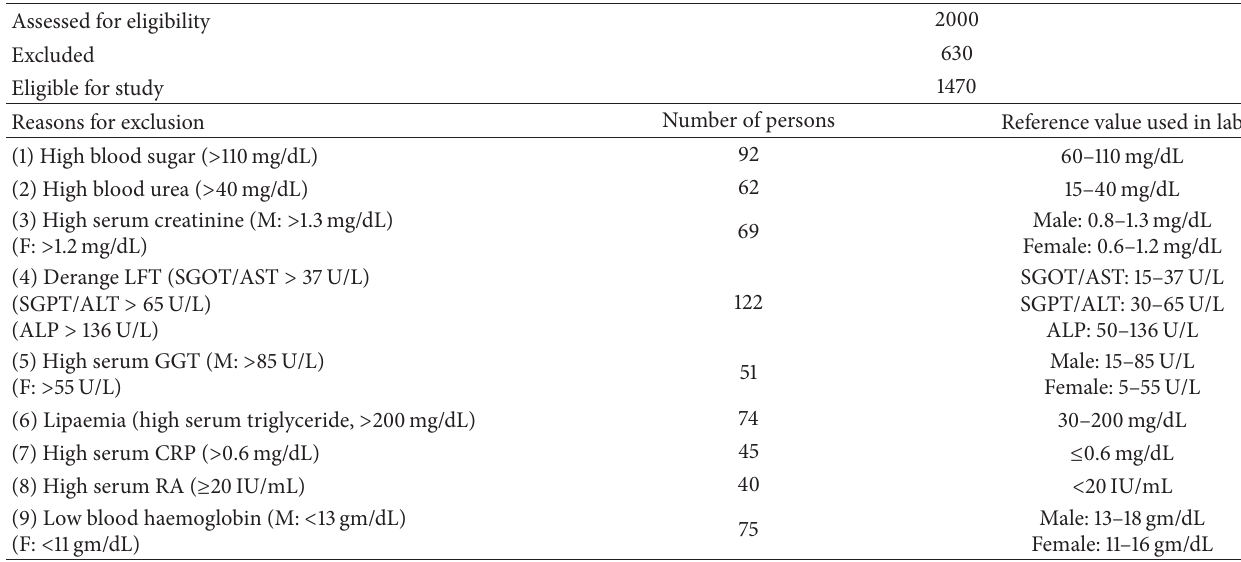
Table 2: Exclusion criteria based on biochemical test results.